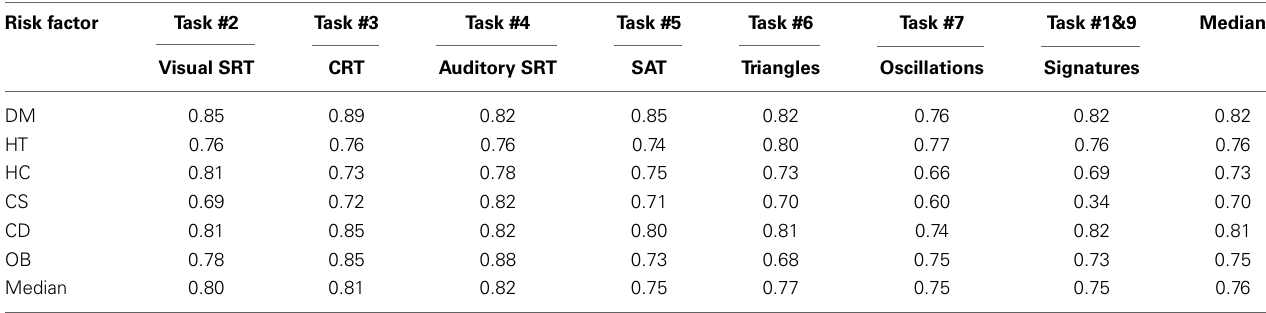
Table 1 | AUC for risk factors classification for the different neuromuscular